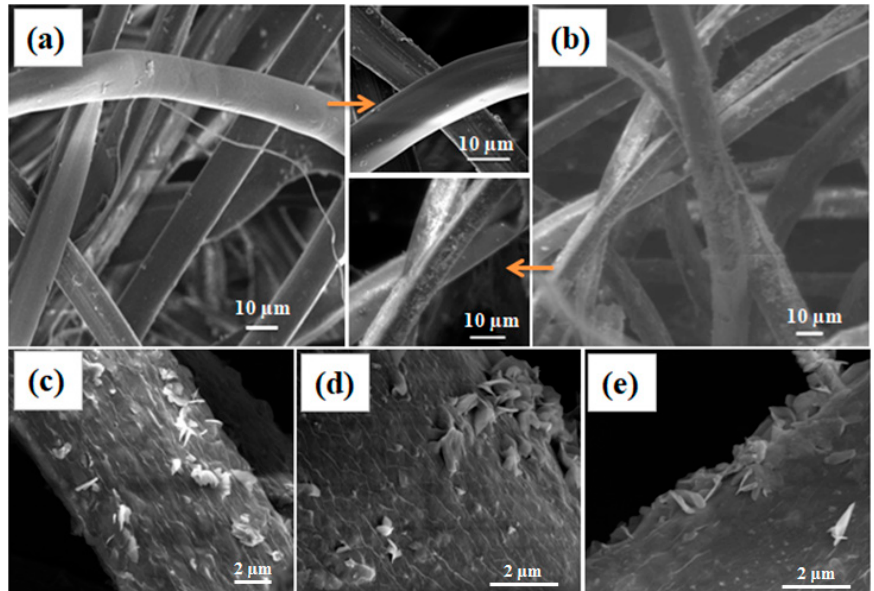
Figure 1. Scanning electron microscopy (SEM) images of ( a ) degummed silk fibers, ( b ) ZnO coated silk fibers. High magnification images from ( b ) are given in ( c ), (d) and ( e ) where ZnO flake type structures are clearly visible.